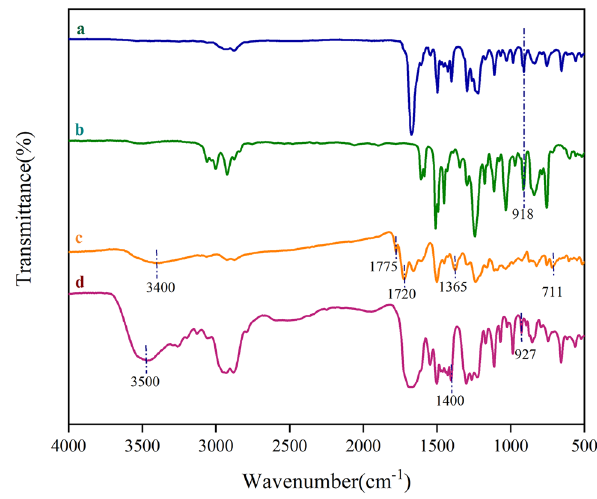
Figure 4: FTIR spectra of ( a ) EP/PAA before curing, ( b ) EP, ( c ) EP/PAA after curing, and ( d )